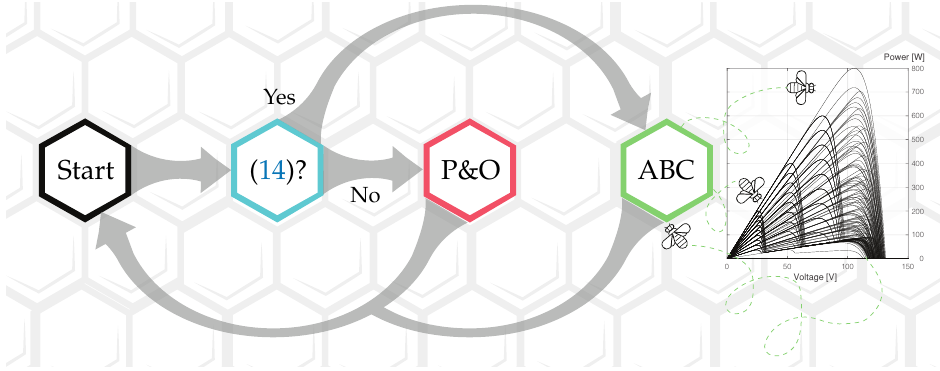
Figure 4. General flowchart of the ABC-P&O MPPT algorithm based on Algorithm